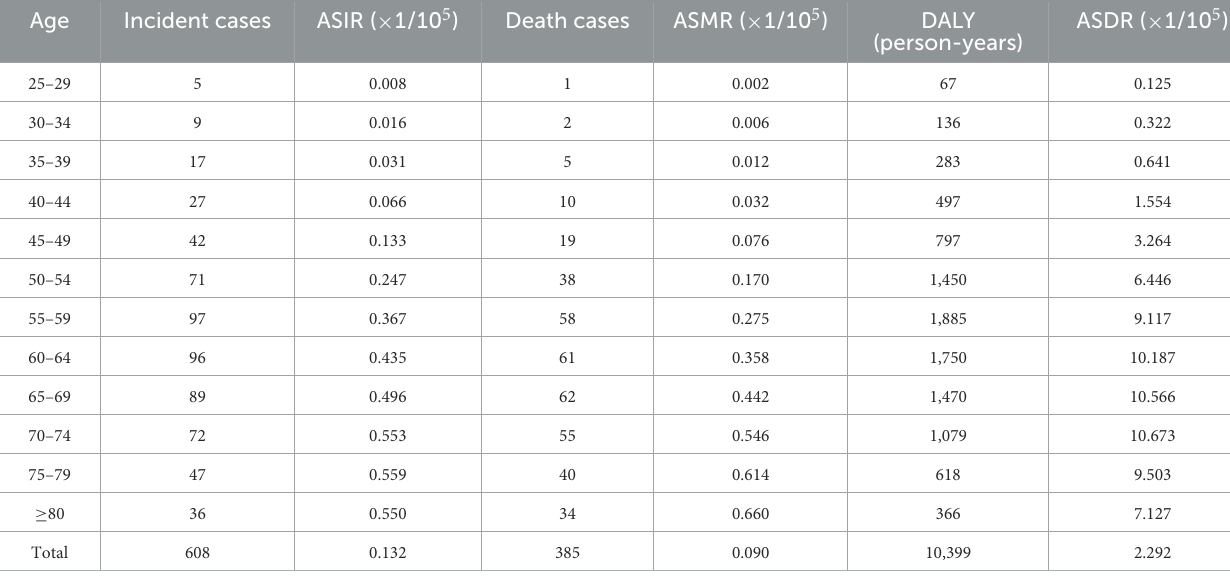
TABLE 3 The age distribution on ASRs of ovarian cancer attributable to hyperglycemia in China, 1990.